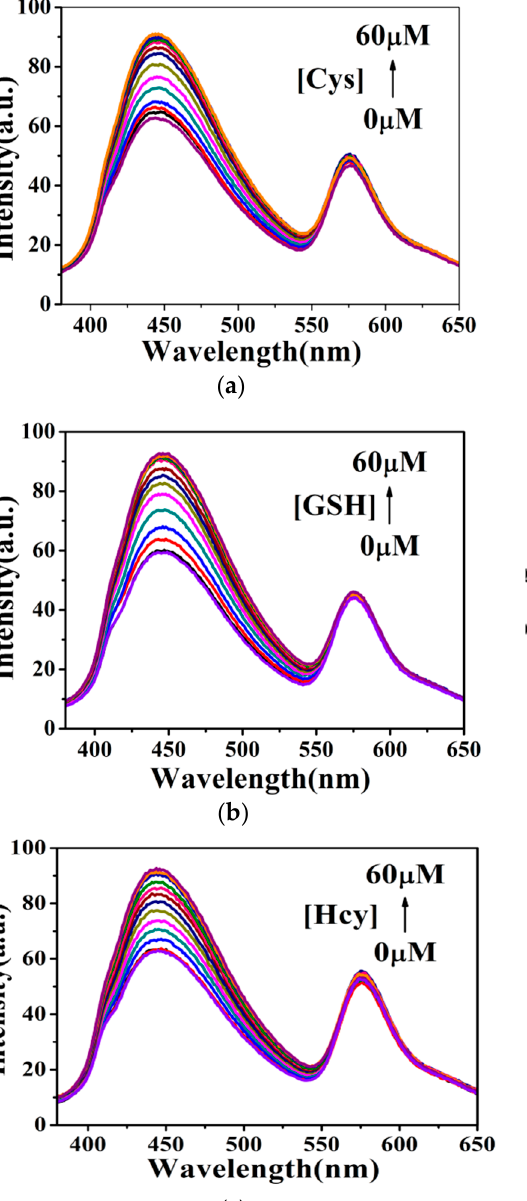
Figure 9. Reversibility of the dual-emission silica microspheres in deionized water by introducing equivalent mole of Hg 2+ and GSH. 4. Conclusions In summary, a ratiometric fluorescent nanosensor for the detection of Hg 2+ and three biothiols has been designed and prepared by coupling CA-AEAPMS on RBS-doped silica microspheres. The obtained fluorescent microspheres exhibit characteristic emissions of RBS and CA-AEAPMS at excitation wavelength (360 nm), and can quench CA-AEAPMS emission when Hg 2+ is combined, resulting in a ratio of fluorescence response of Hg 2+ in aqueous solution. The selective experiments shows that this ratiometric fluorescence nanosensor is more selective for Hg 2+ than other ions. The